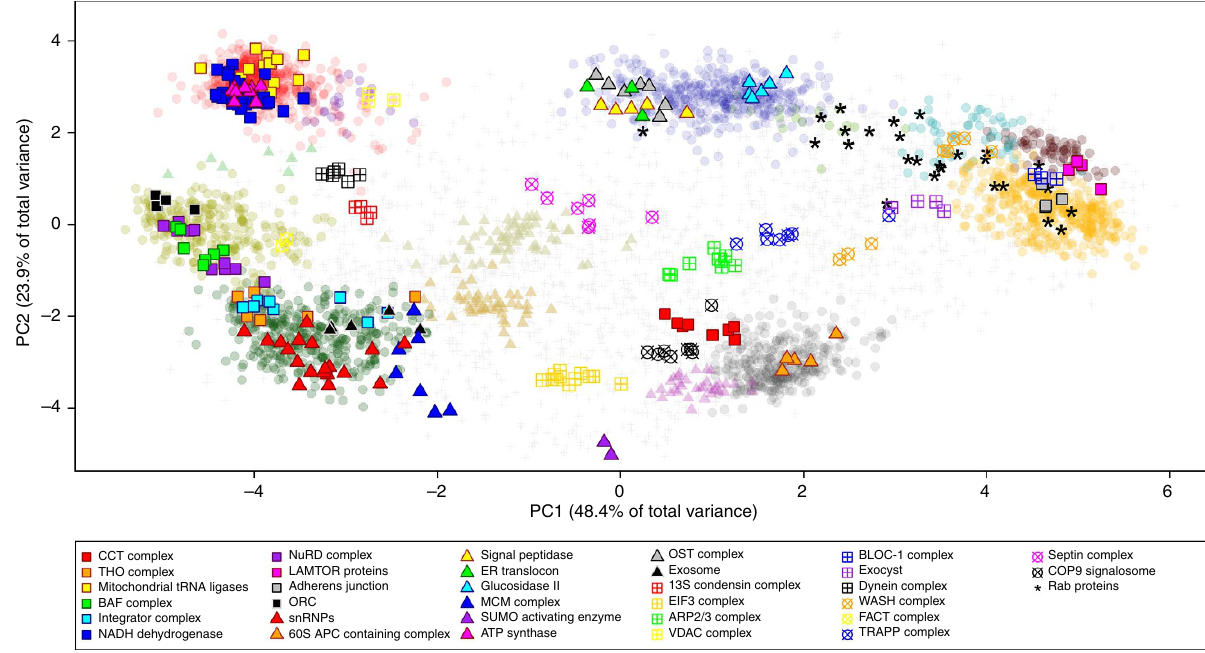
Figure 5 | Examples of soluble and organellar protein complexes. Protein complexes are distributed throughout principal component space. Some soluble protein complexes display characteristic distributions that may reflect mixed localization, partitioning of the cytoskeleton by the fractionation scheme, or the unique sedimentation properties of these macromolecular structures. Sub-organellar distribution of complexes were observed in both ER, mitochondrion and